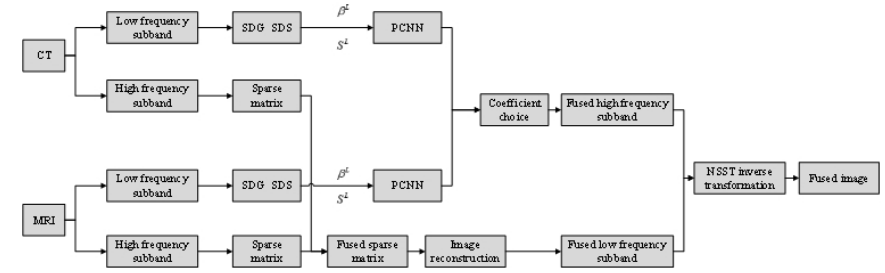
Fig. 2. Proposed fusion